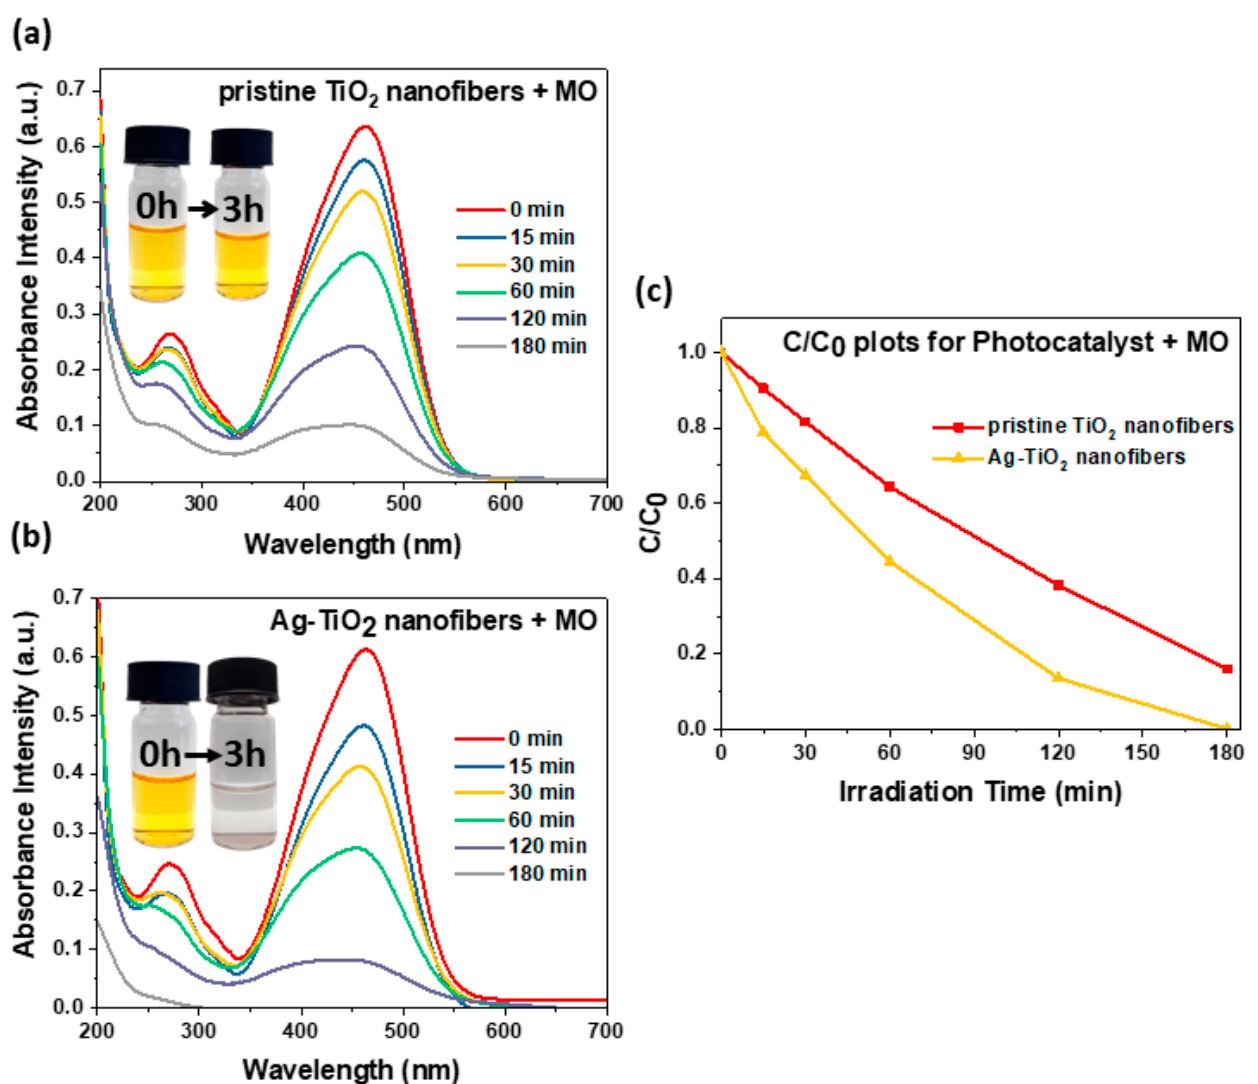
Figure 5. Photodegradation study of methyl orange (MO) dye under solar irradiance with ( a ) pristine TiO 2 nanofibers and ( b ) Ag-TiO 2 nanofibers; ( c ) C/C 0 plots for the two dye degradation setups, where the red line represents the pristine TiO 2 nanofibers, while the yellow line represents the Ag-TiO 2 nanofibers.